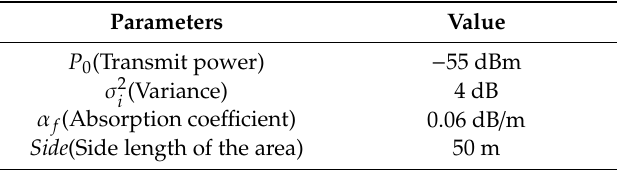
Figure 7. RMSE versus variable N with P 0 = − 55 dBm, σ 2 length of the cube Side = 50 m. Table 5. Parameters in the scenario with variable N .